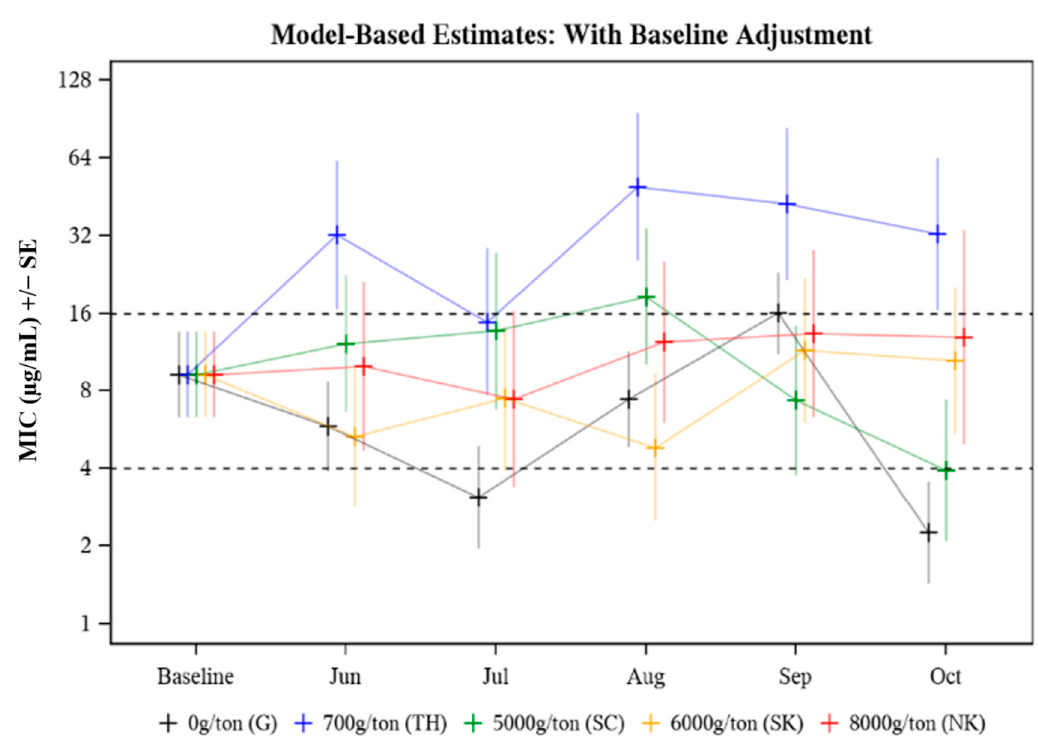
Figure 1. Model-based estimates of median minimum inhibitory concentration (MIC) for E. coli isolated from cattle herds provided different FDA-approved CTC-medicated mineral formulations to control A. marginale. Baseline adjusted MIC for E. coli recovered from cattle treated with different CTC-medicated mineral formulations for six months.